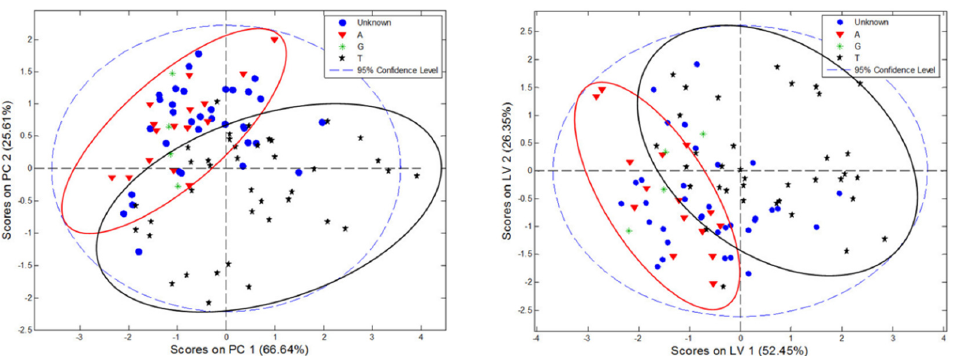
Figure 2. PCA ( left ) and PLS − DA ( right ) score plots for C. incanus parameters modeling (A, Albanian; Figure 2. PCA (left) and PLS − DA (right) score plots for C. incanus parameters modeling (A, Alba- G, Greek, T, Turkish plant material). nian; G, Greek, T, Turkish plant material).